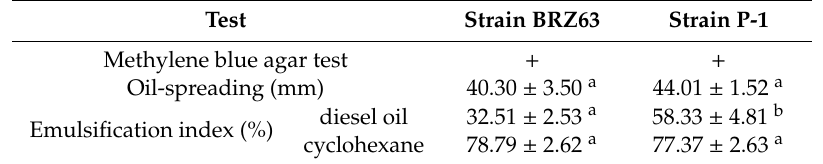
Table 3. Biosurfactant production by P. fluorescens BRZ63 and the control Pseudomonas sp.